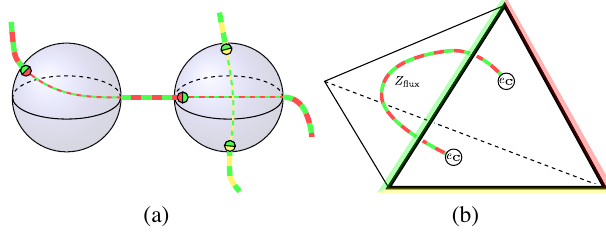
FIG. 16. (a) An example of a flux loop, where the correspond- ing colored strings on the dual lattice are depicted; the shaded blue spheres represent b -colored 3-cells. [The constraint from Eq. (45) requires an even number of flipped rg plaquettes on a y - colored 3-cell]. (b) An rg -colored flux loop of flipped G Z (coming from a string of X operators) terminating with a pair of e anyons on the outer C